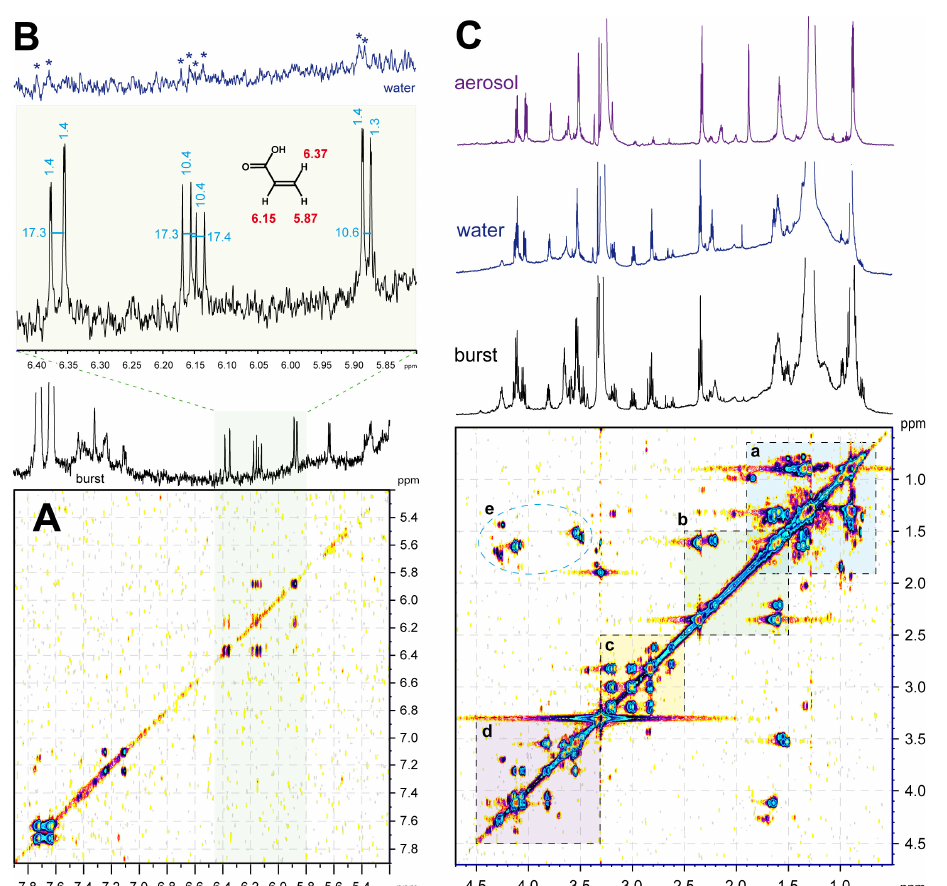
Fig. 8. 500MHz NMR spectra of surface water, burst, and aerosol in CD 3 OD ( δ H =3.30ppm). (A) : section of unsaturated protons with an Figure 8: 500 MHz NMR spectra of surface water, burst, and aerosol in CD 3 OD (  H = 3.30 olefinic spin system tentatively assigned as acrylic acid (red: chemical shifts [ppm], blue: J couplings [Hz]); a few neutral aromatics resonate ppm). Panel A: section of unsaturated protons with an olefinic spin system tentatively from δ H ∼ 7.1...7.4ppm; the large NMR peaks at δ H ∼ 7.6...7.8ppm represent exchangeable protons, likely from phenolics or peptides. (B) : section of unsaturated protons in ocean surface water, indicating small amounts of acrylic acid (asterisks); small pH variations cause minor chemical shift displacement with respect to those of burst sample shown in (A) . (C) : aliphatic section of 1 H, 1 H COSY NMR spectrum of marine burst sample together with 1 H NMR projection spectra of burst, surface water and aerosol and key substructures indicated. Section a: intra aliphatic HC-HC-HC-CH cross peaks with methyl ( δ H < 1ppm) and within branched aliphatics; section b: functionalized aliphatics connected with carbonyl derivatives C-HC-HC-COX (COX=COOH, COOR, CONH); note the absence for cross peaks further downfield from ( δ H > 2.4ppm), which excludes oxygenated spin systems (HC-O-); section c: functionalized molecule with several remote heteroatoms Z-C-HC-CH-C-O [Z=O (N)]; section d: -O-HC-CH-O- cross peaks, esters, ethers and alcohols; section e: cross peaks HC-HC-HC-O- connecting aliphatics with oxygenated